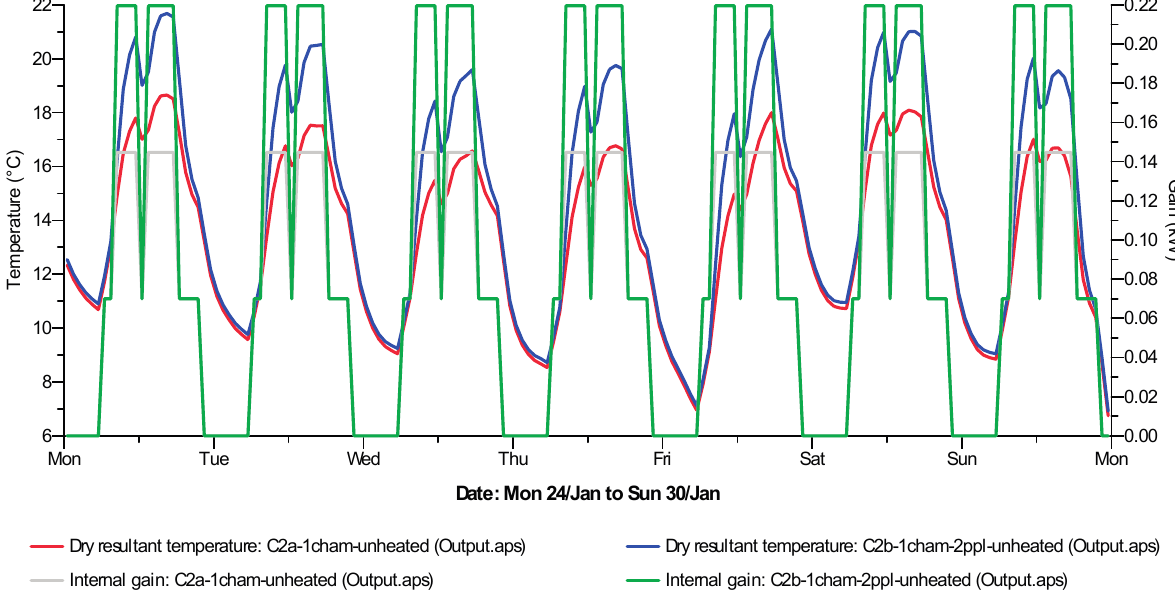
Figure 10. Predicted weekly indoor temperatures and internal heat gains for Cases 2a and 2b.